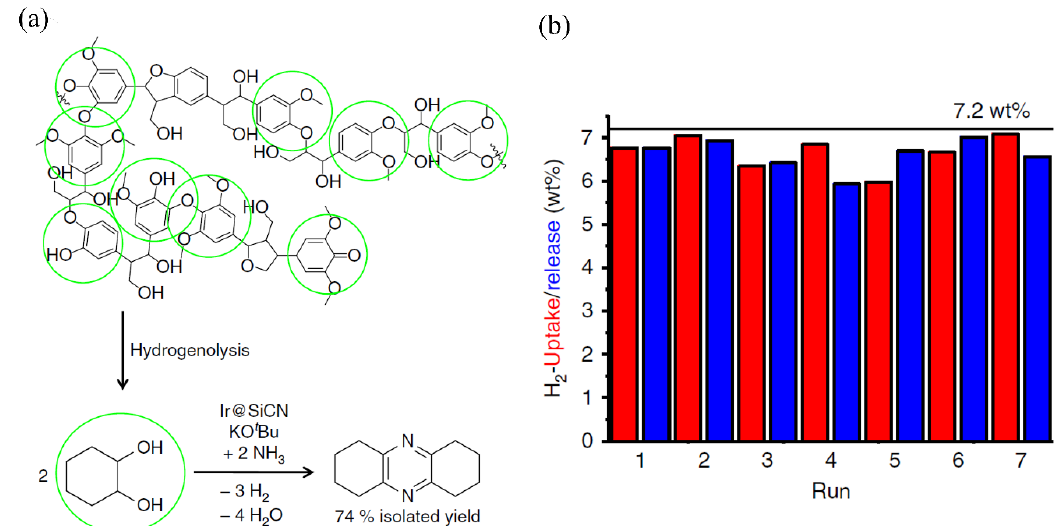
Figure 10. The schematic illustration of perhydro-phenazine/phenazine LOHC system.